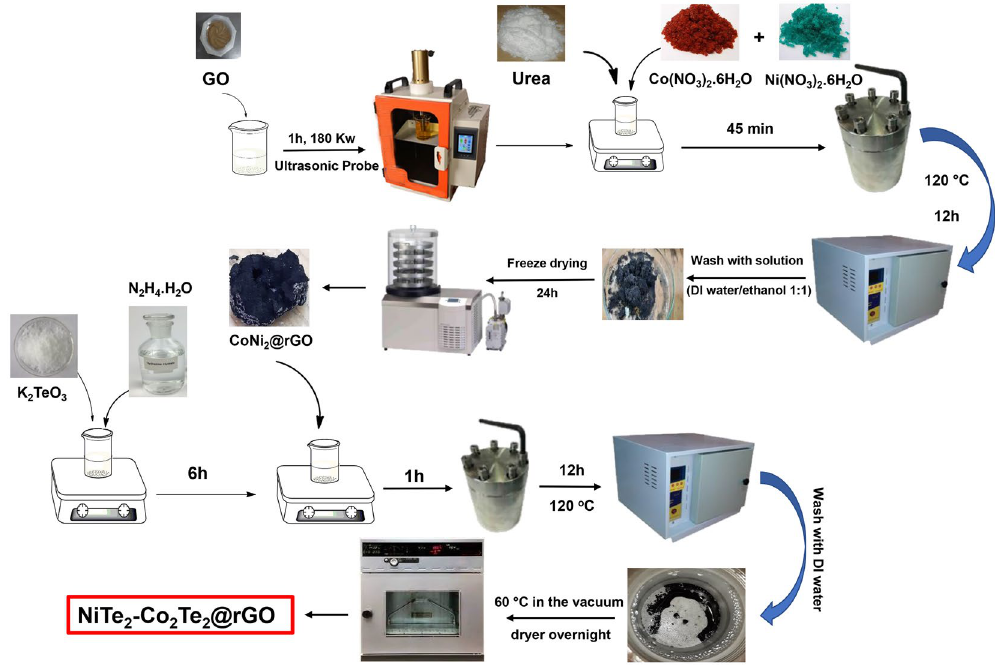
Figure 7. The synthesis procedure of NiTe 2 -Co 2 Te 2